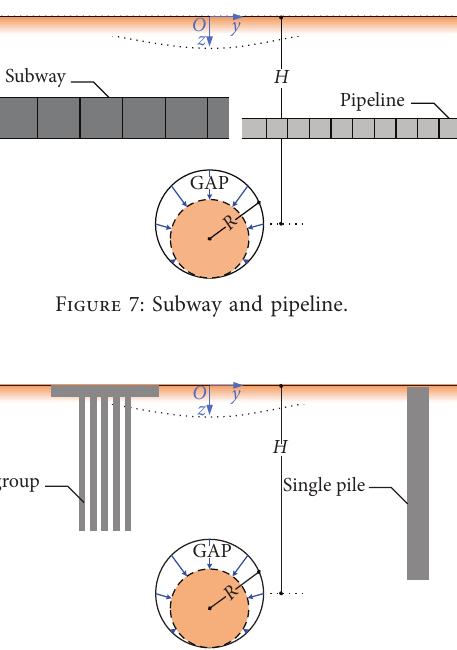
Figure 8: Single pile and pile